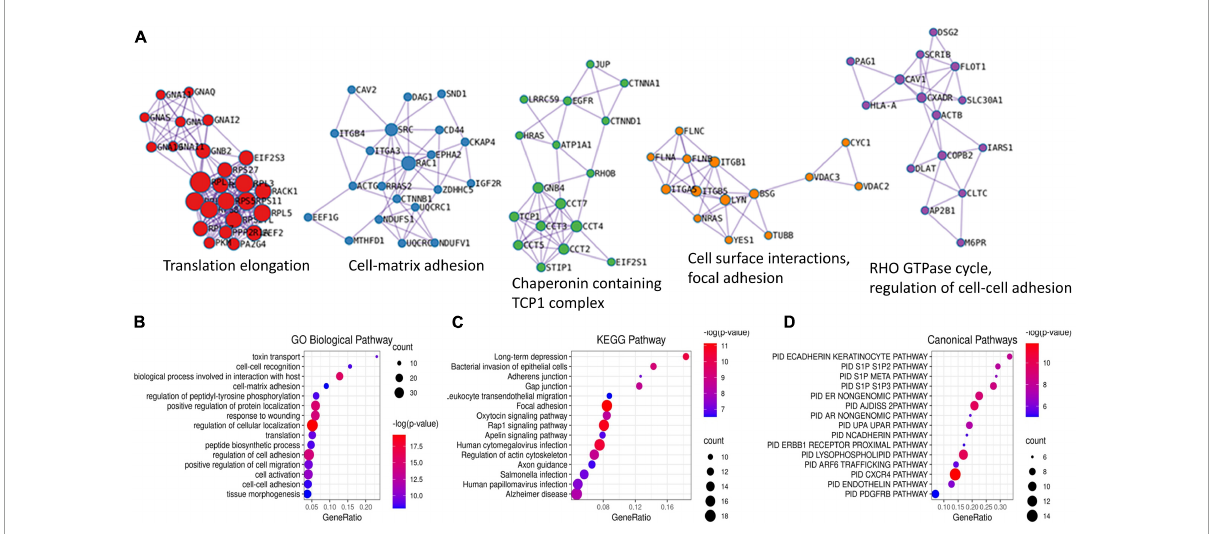
FIGURE3 Enrichment analysis of all potentially palmitoylated proteins identified in RPE cells using Metascape. Five MCODE complexes were identified (A) . The top 15 most significant Gene Ontology (GO) biological pathways (B) , KEGG pathways (C) , and Canonical pathways (D) were presented by bubble graphs. The color and size of each bubble indicated the value of –log( p -value) and enriched gene counts, respectively.